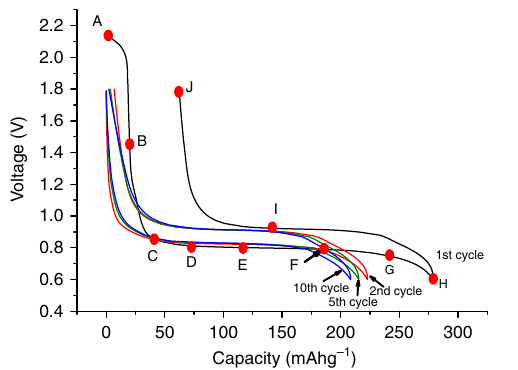
Figure 3 | Variation of potential (versus Li þ /Li) with state of charge for Li(V 0.5 Ti 0.5 )S 2 . Rate 100mAg (cid:2) 1 . Letters correspond to various states of charge on the 1st cycle, see also Fig. 5.